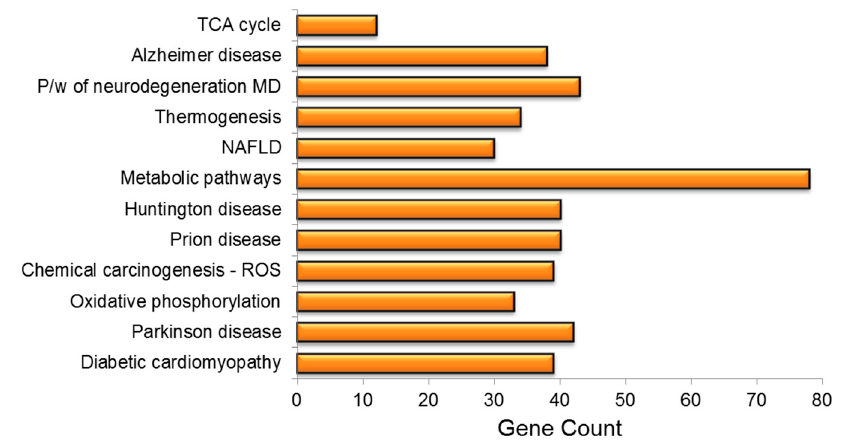
Figure 5. KEGG pathway enrichment analysis of mrfDEGs. TCA: tricarboxylic acid cycle, P/W: pathway, MD: multiple disease, NAFLD: non-alcoholic fatty liver disease, ROS: reactive oxygen species.